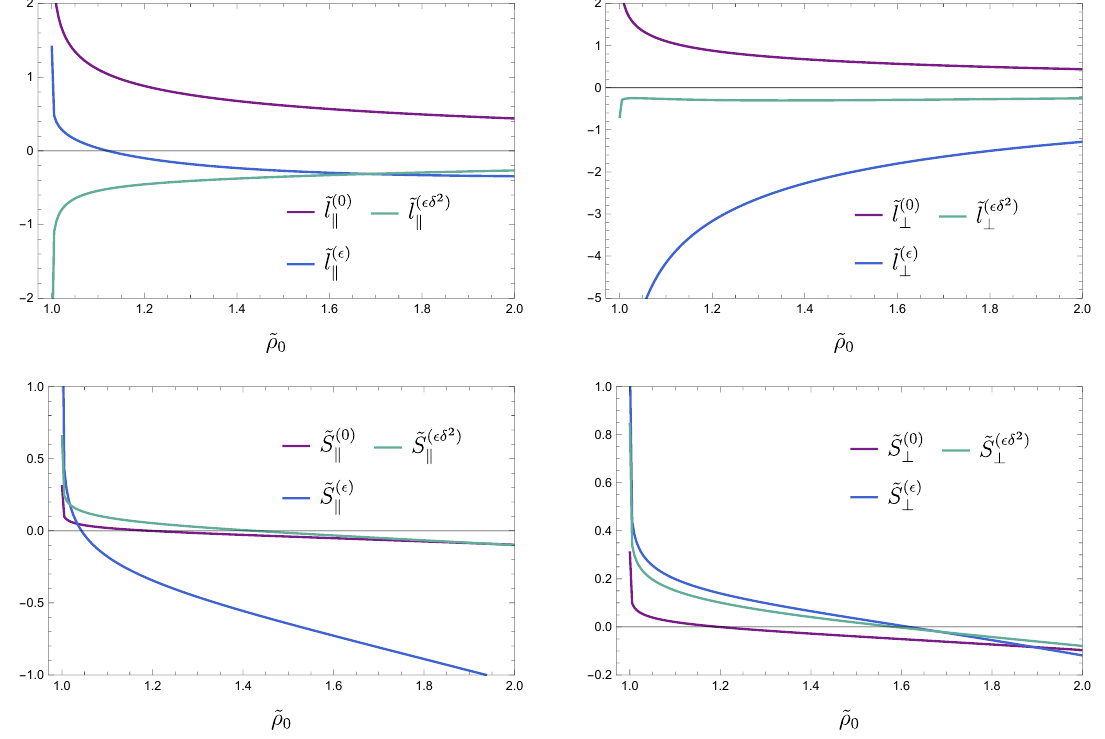
Figure 5 . Comparison between the corrections at different orders of the widths and entanglement entropies, defined in way similar to (6.16).